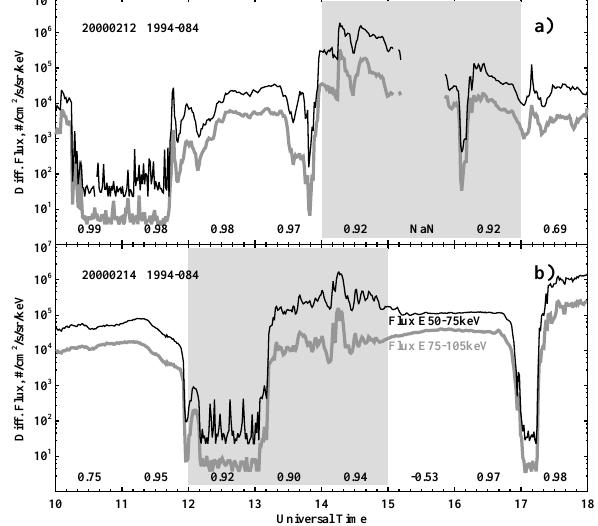
Fig. 8. SOPA spin-averaged electron flux measurements at 1-min resolution for (a) 12 and (b) 14 February 2000, 10:00–18:00 UT. The highlighted areas correspond to the periods of very high cor- relation from Fig. 2. The digits at the bottom of each panel show the correlation coefficients between the fluxes at two lowest energy channels for each 1-h